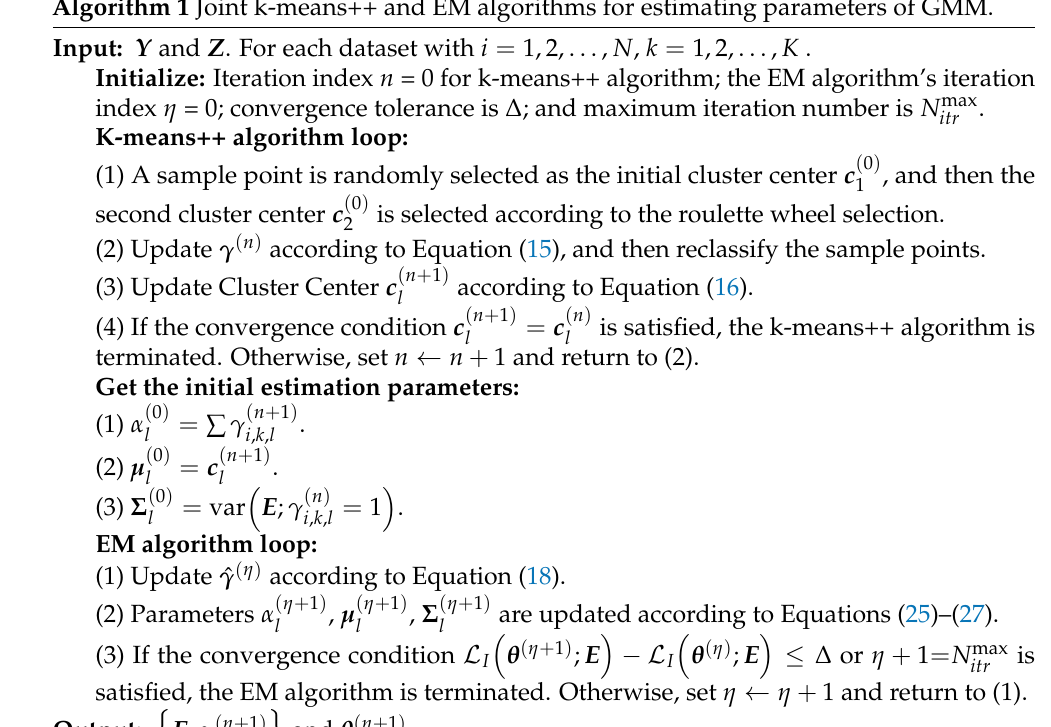
Algorithm 1 Joint k-means++ and EM algorithms for estimating parameters of